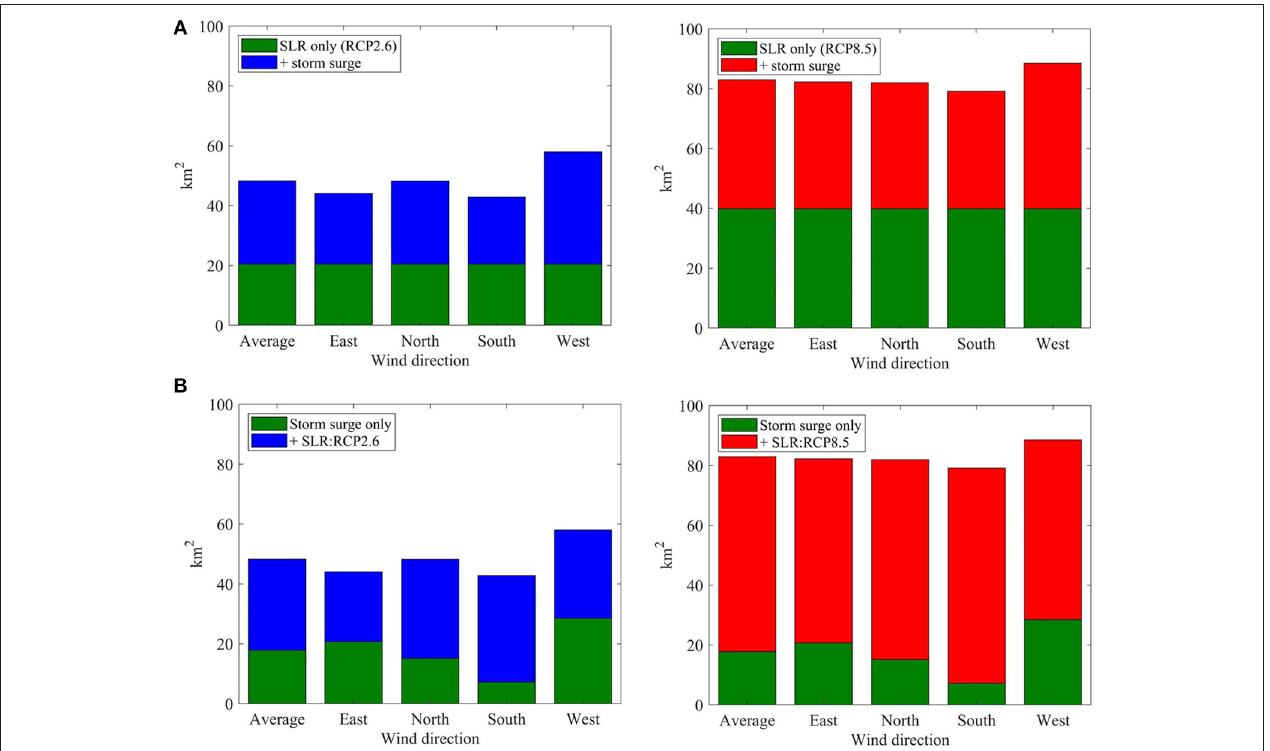
FIGURE 10 | Compound effects on the total inundation area by SLR and storm surge (left: RCP2.6 scenario, right: RCP8.5 scenario). (A) Contribution of storm surge to total inundation area, (B) Contribution of SLR to total inundation area.